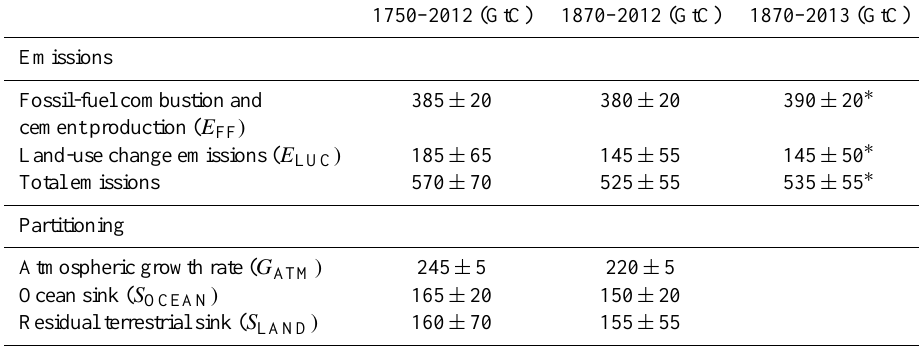
Table 10. Cumulative CO 2 emissions for the periods 1750–2012, 1870–2012 and 1870–2013 in GtC. All uncertainties are reported as ± 1 σ . All values are rounded to nearest 5 GtC as in Stocker et al. (2013b), reflecting the limits of our capacity to constrain cumulative